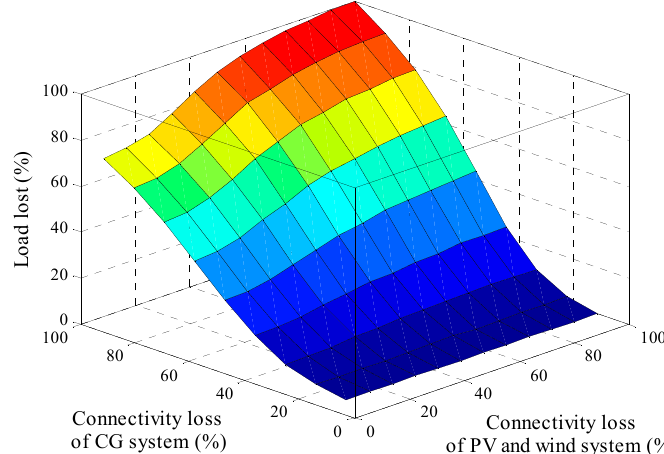
Figure 32. Vulnerability evaluation. (Distributed renewable and CG systems under CIC).